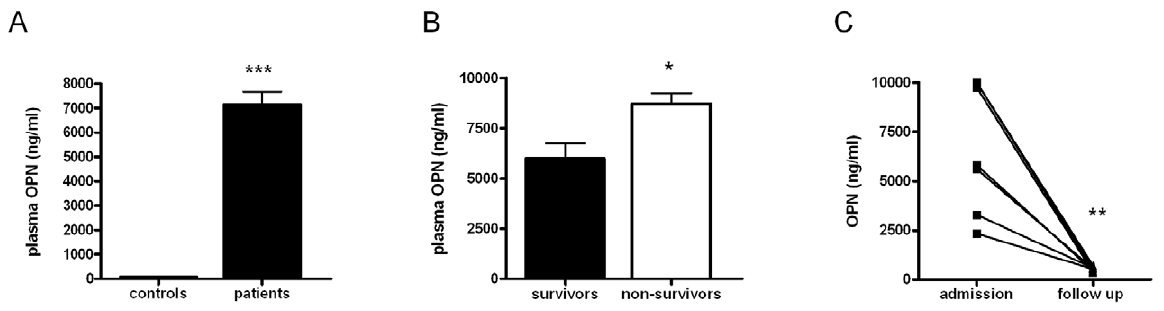
Figure 1. OPN plasma levels are elevated in patients with melioidosis and correlate with mortality. OPN plasma concentrations in (A) healthy controls versus melioidosis patients (n=31 and n=33, respectively), (B) survivors versus non-survivors (n=19 and n=14, respectively), and (C) patients at admission versus follow up sampling (n=8). Data are expressed as means 6 SEM, * P , 0.05, ** P , 0.01 and *** P , 0.001.